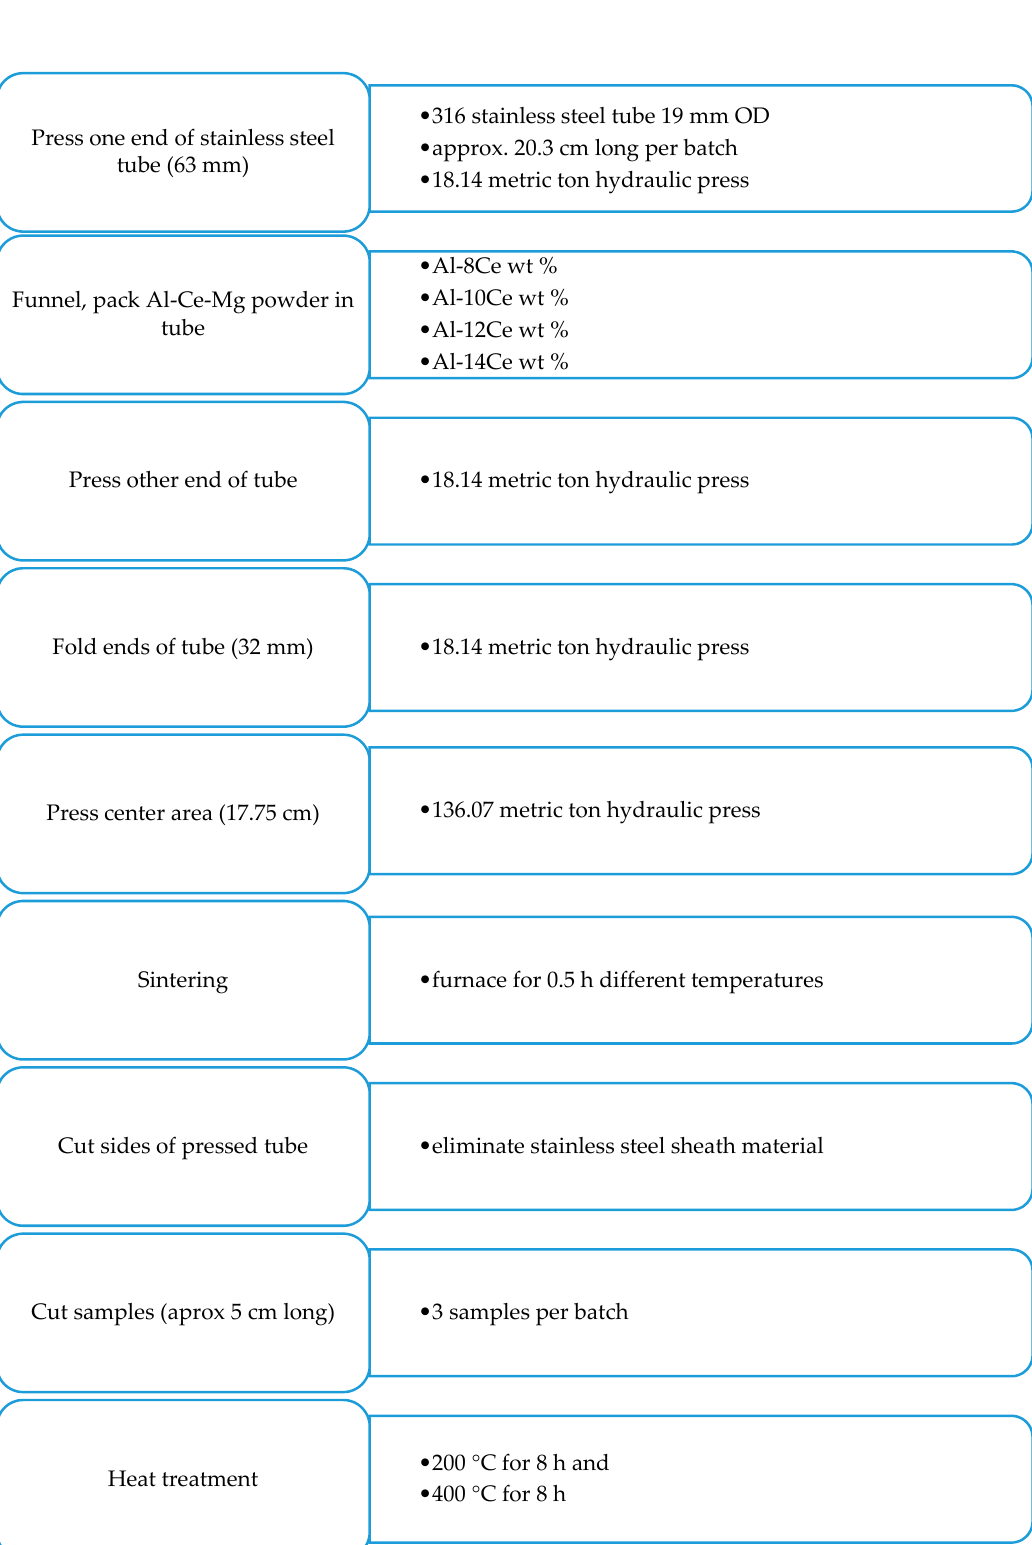
Figure A2. Powder-in-tube process for Al-Ce powder samples.